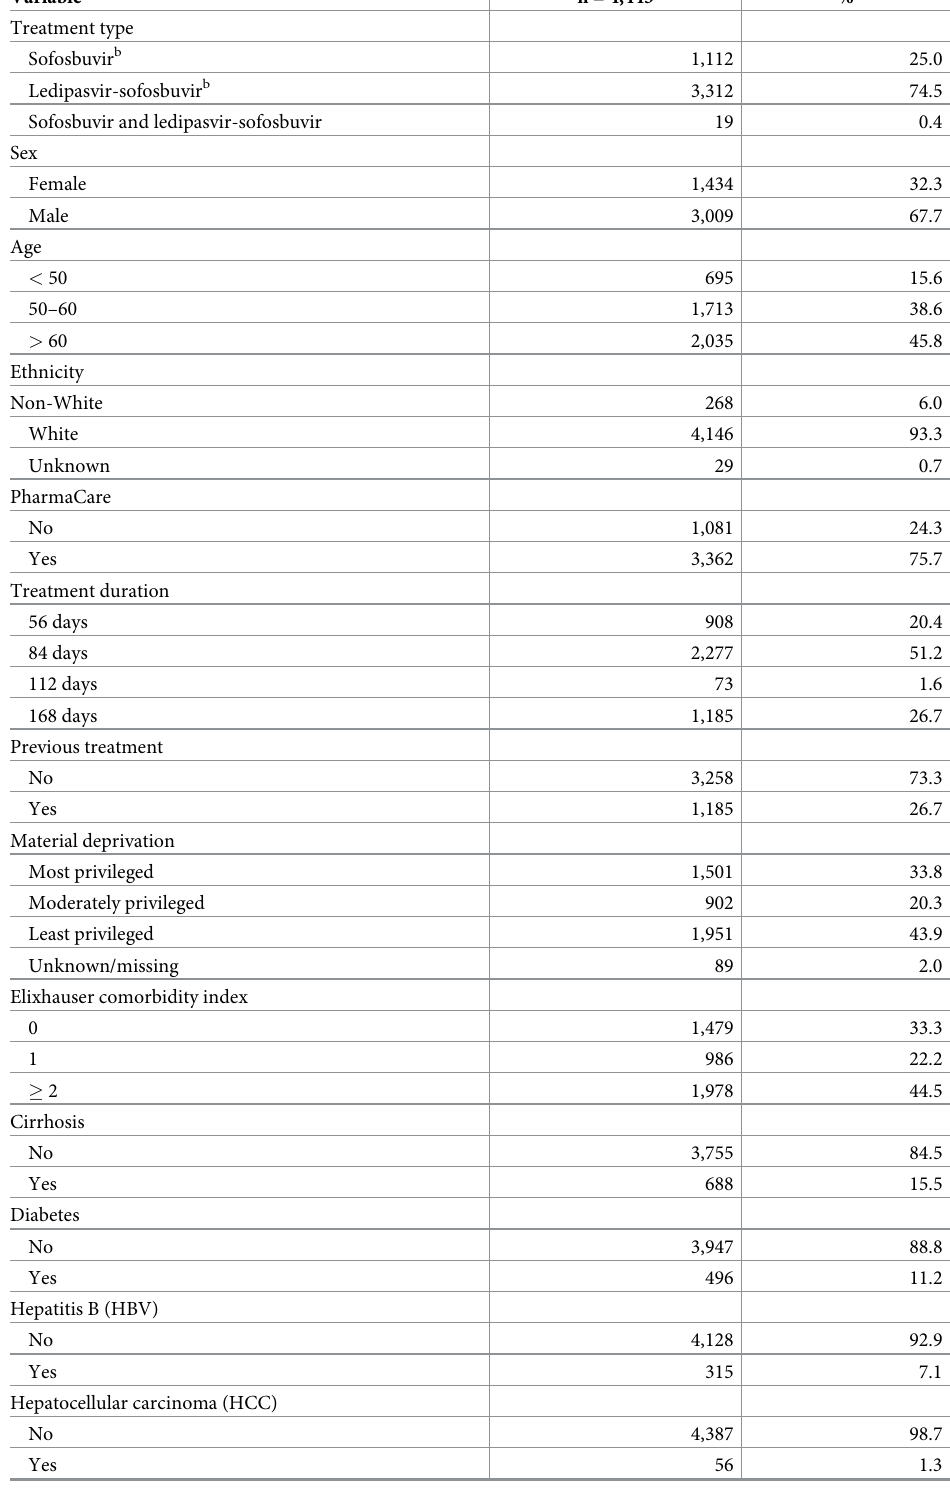
Table 1. Characteristics of eligible patients treated on sofosbuvir and ledipasvir-sofosbuvir in British Columbia a